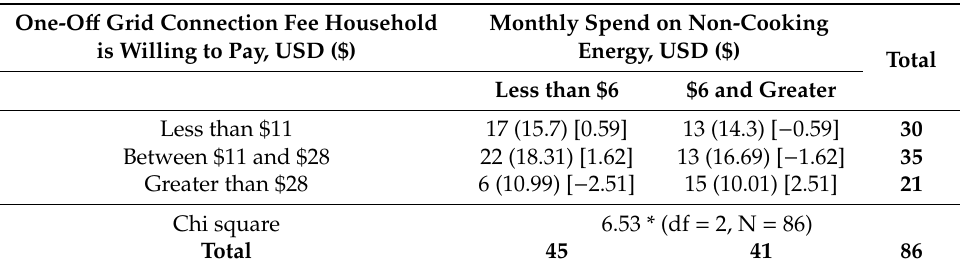
Table 7. Association between amount households are willing to pay for one-o ff grid connection fee and the monthly spend on non-cooking energy,